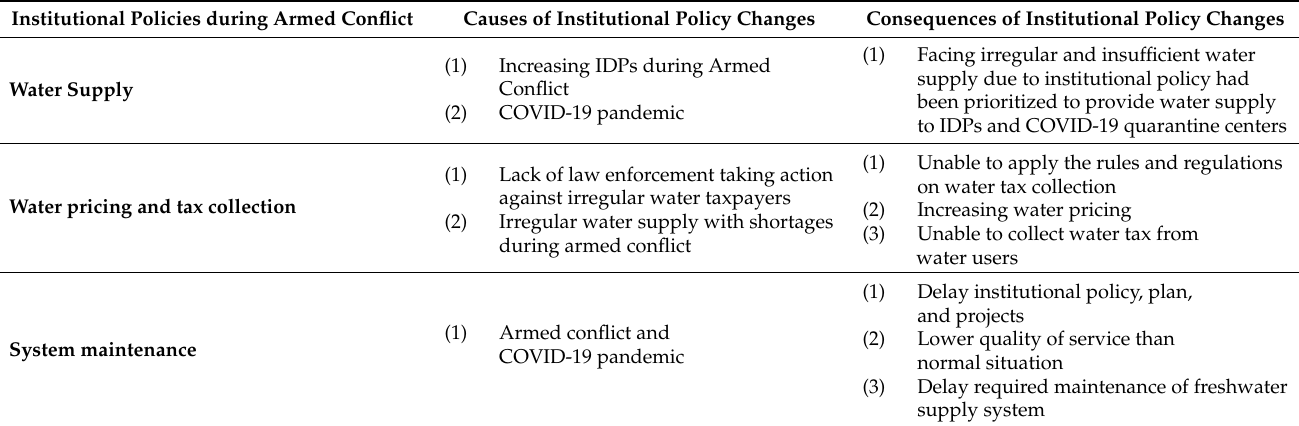
Table 4. Stakeholder perceptions on causes and consequences of institutional policy changes during armed